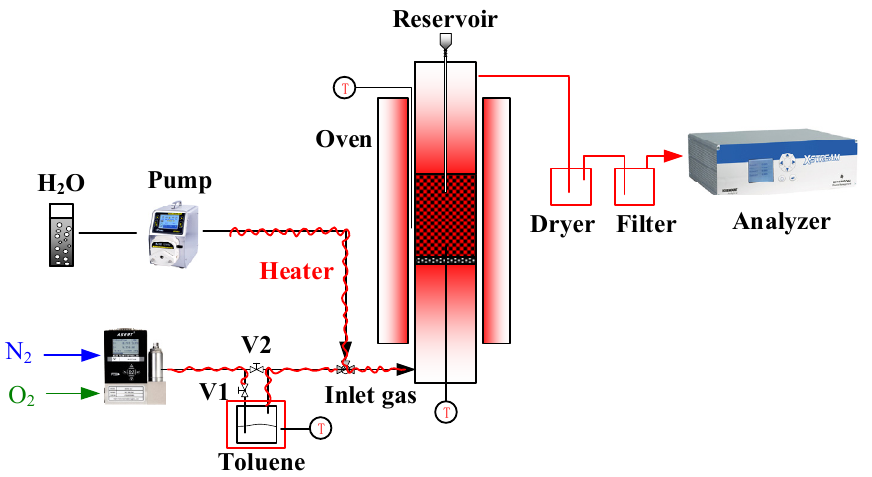
Figure 2. The diagram of the fixed bed for the chemical looping conversion of toluene.